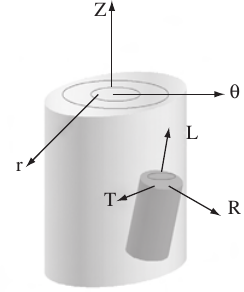
Figure 4. Cartesian and Cylindrical axes for